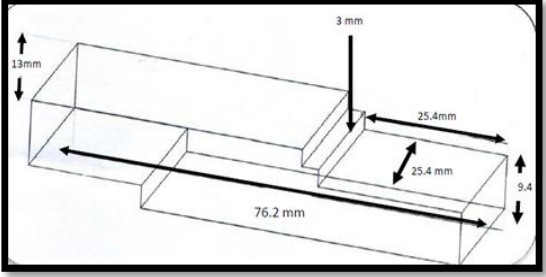
Figure 2: Dimension of shear bond strength specimen